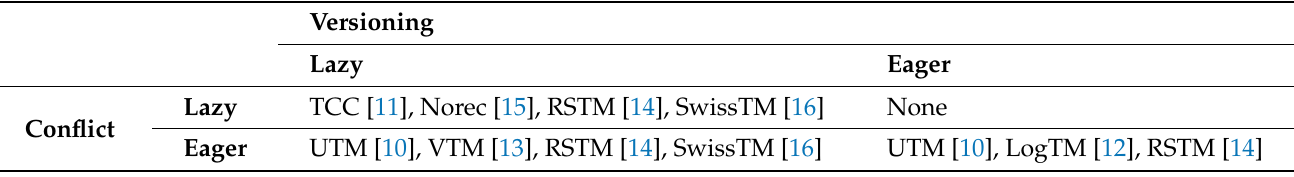
Table 2. Versioning and conflict detection mechanisms used in some non-persistent TM